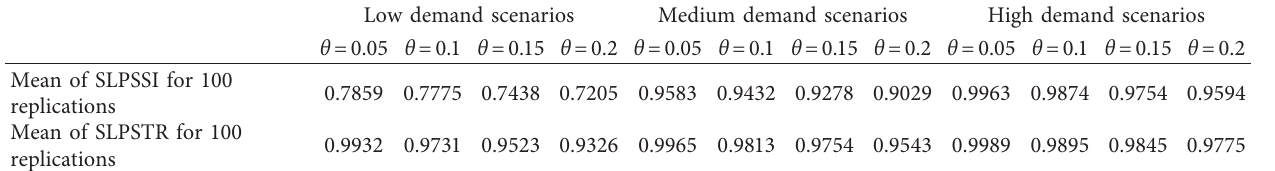
Table 8: The average SLPSSI and SLPSTR for successive iterations in the three